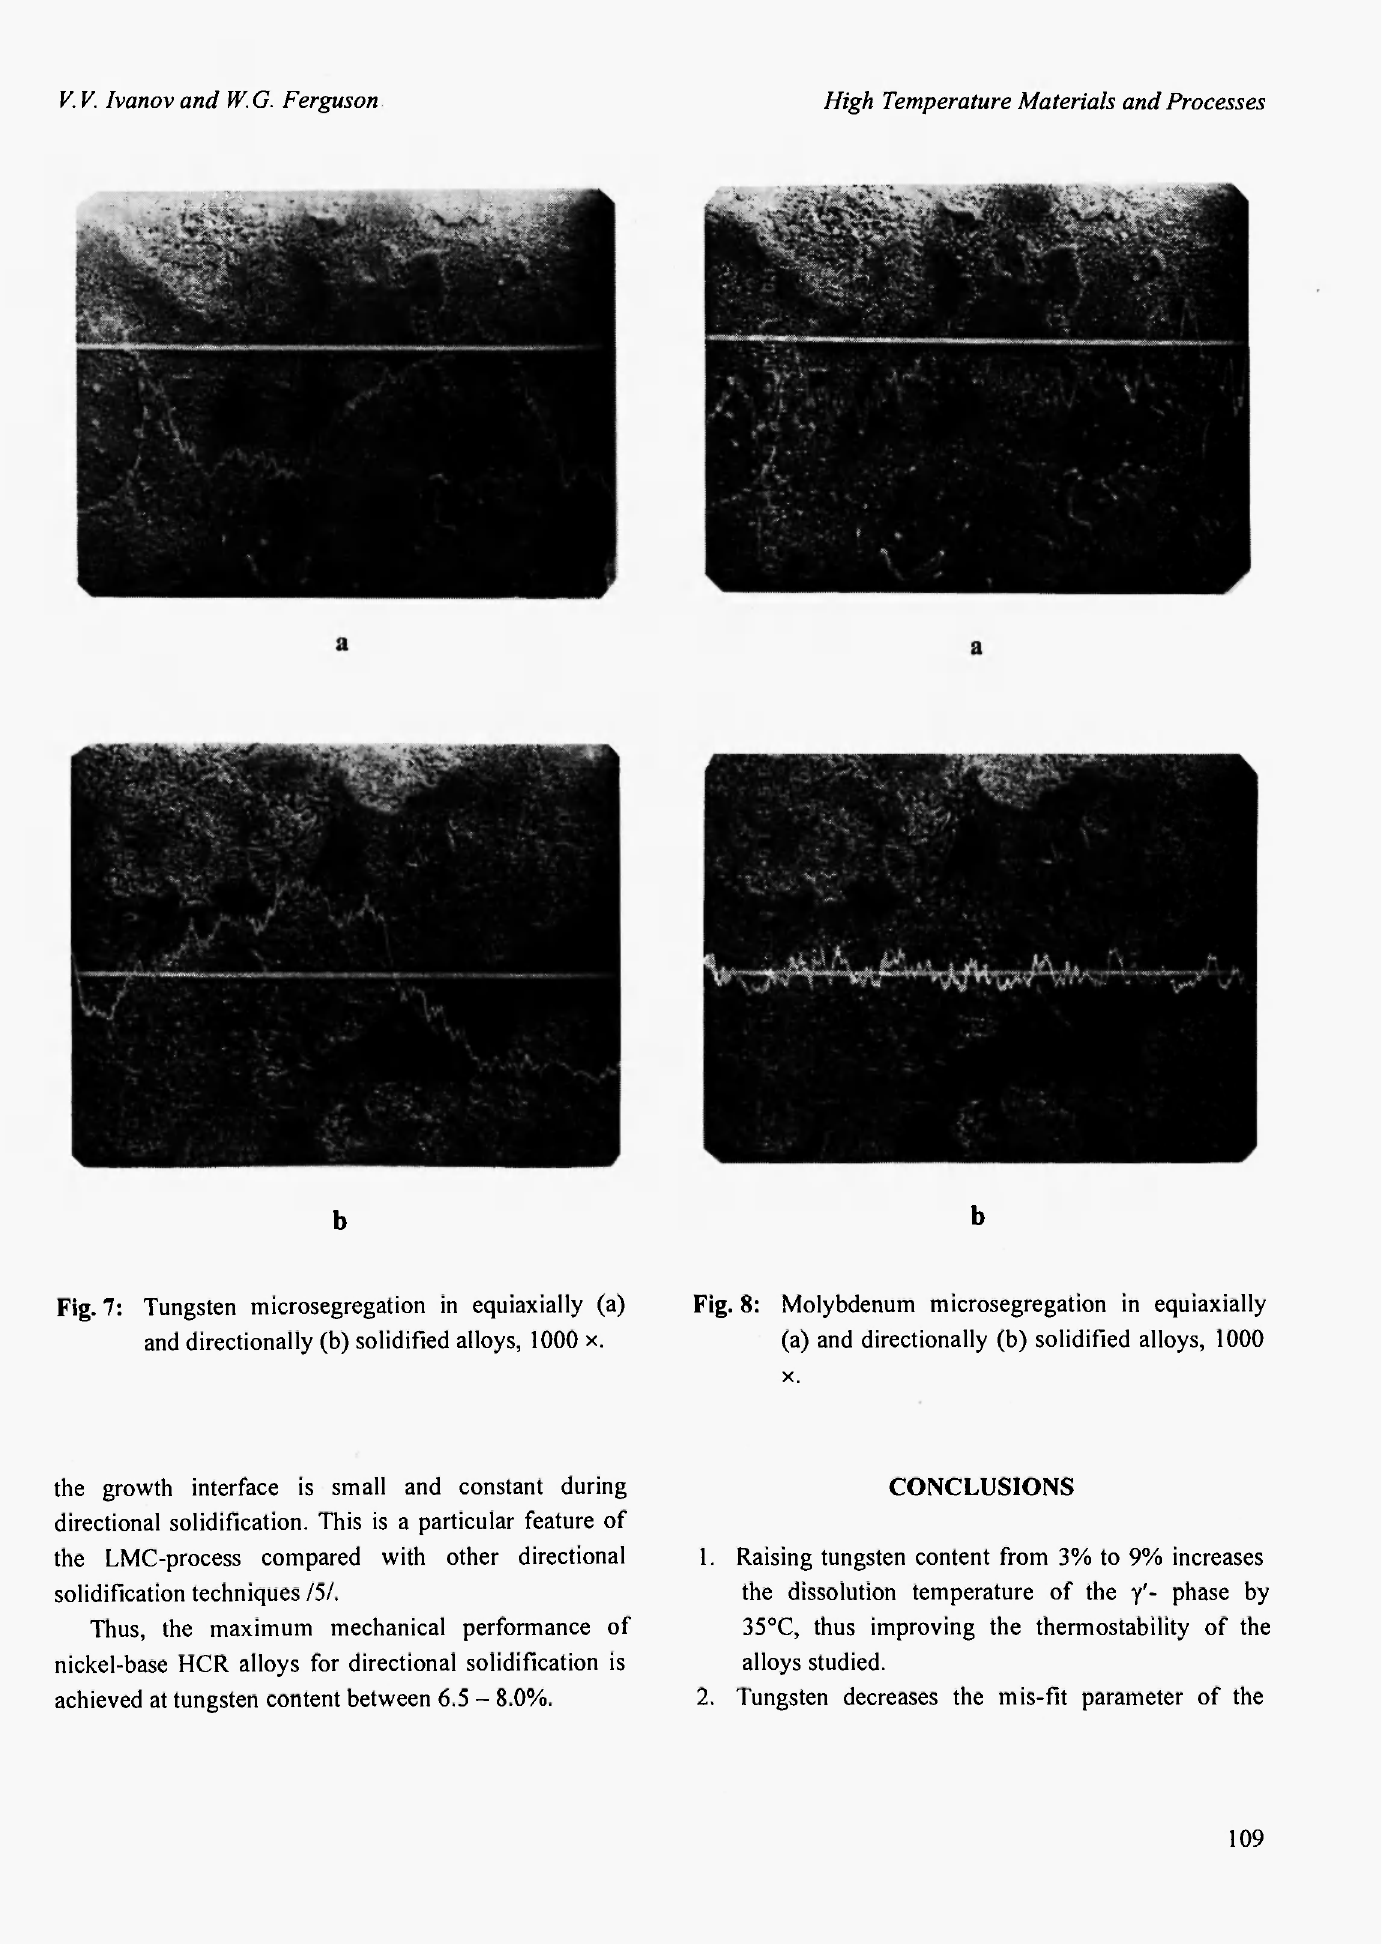
Fig. 8: Molybdenum microsegregation in equiaxially (a) and directionally (b) solidified alloys, 1000